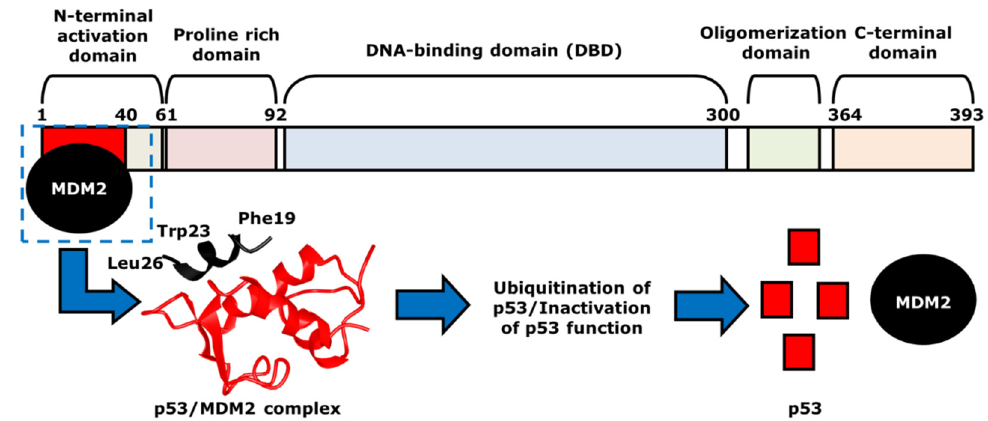
Figure 3. The mechanism of p53- and MDM2-binding. MDM2, indicated as black, binds to p53 at the N-terminal activation domain of p53, or the red area, to form p53/MDM2 complex. The two proteins are in direct contact via hydrogen bonding, with hydrophobic p53 residues Phe19, Trp23 and Leu26 that help such interaction. The structure of the p53/MDM2 complex, which is shown with the corresponding colors, black and red, leads to the ubiquitination and the proteasomal degradation of p53. This results in the inhibition of the transcriptional activity of p53.